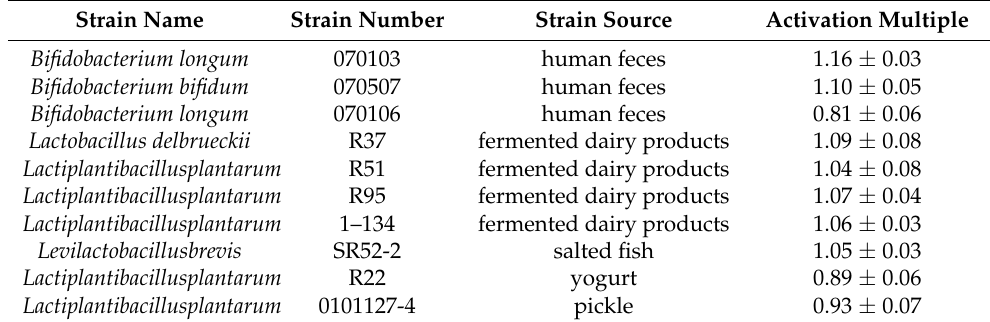
Table 1. Screening of glucokinase activator in vitro.